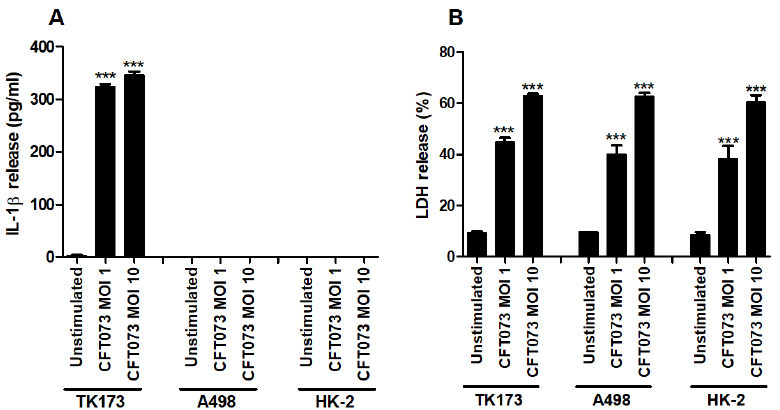
Figure 1. IL-1 β and LDH release during a UPEC infection. Renal fibroblasts (TK173) and renal Figure 1. IL-1β and LDH release during a UPEC infection. Renal fibroblasts (TK173) and renal epi- epithelial cells (HK-2 and A498) were infected with UPEC strain CFT073 at MOI 1 or MOI 10 for 6 h followed by analysis of IL-1 β ( A ) and LDH release ( B ). Data are presented as mean ± SEM ( n = 3 independent experiments). Asterisks over bars denote statistical significance compared to respective Cells 2021 , 10 , x unstimulated control (*** p < 0.001).